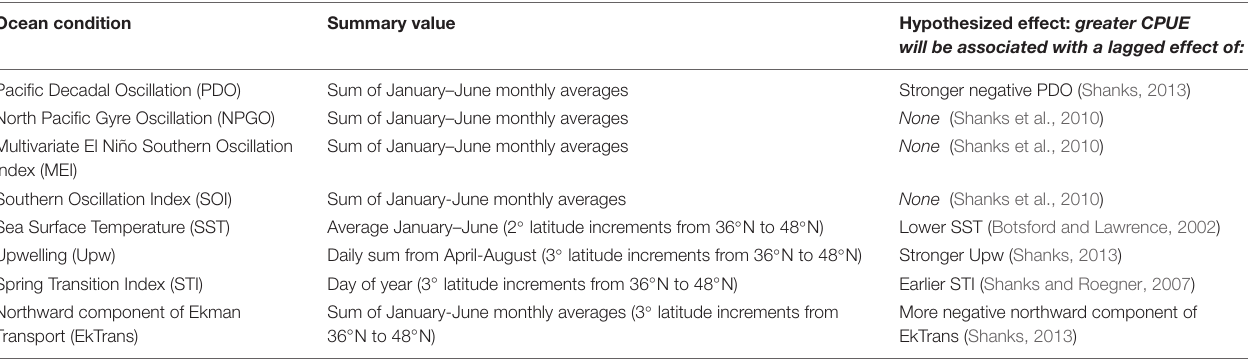
TABLE 1 | List of ocean conditions analyzed for their relationship to Dungeness crab commercial catch per unit effort (CPUE) across the U.S. west coast, description of how the ocean condition value was summarized for analysis, and its hypothesized effect on CPUE. Ocean condition Summary value